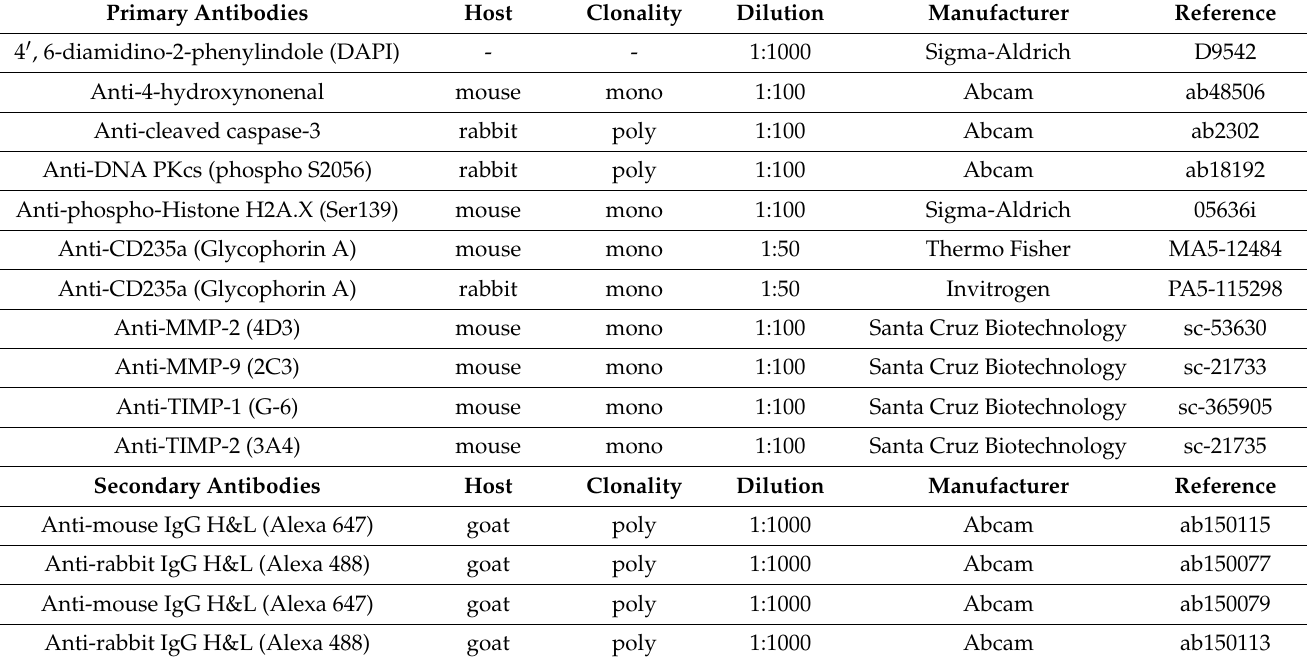
Table 2. List of